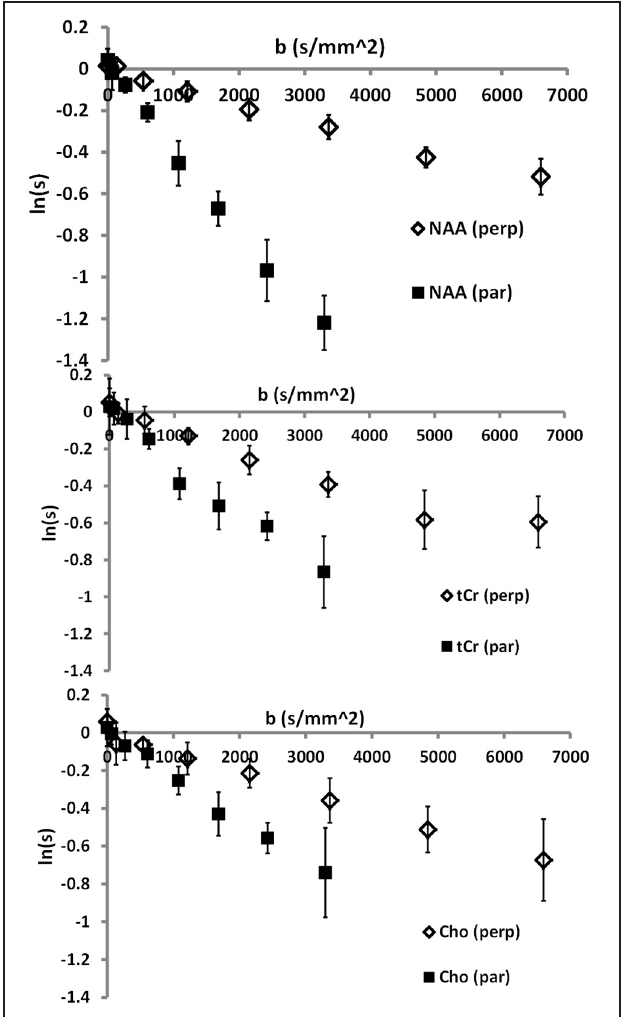
FIGURE 5 | Group-averaged data for the three main metabolites: top—tNAA; middle—tCr; bottom—tCho.